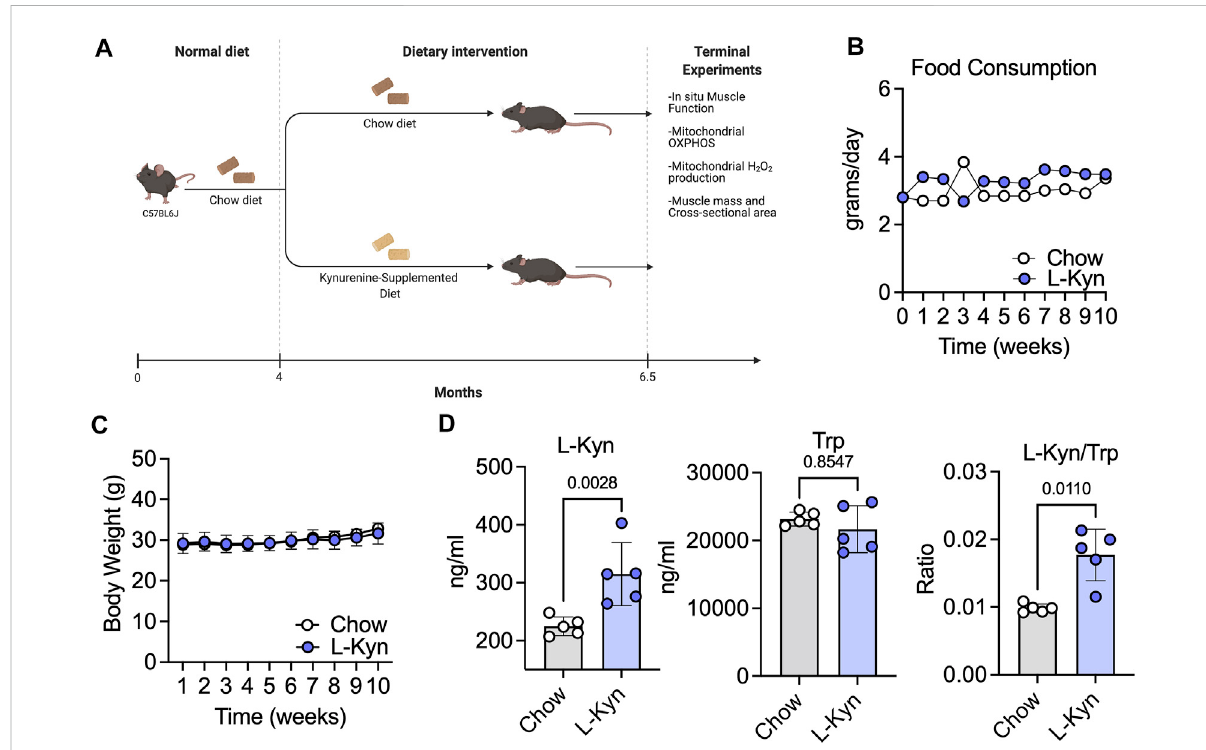
FIGURE 1 L-KynsupplementeddietincreasesplasmaL-KynlevelsandtheL-Kyn/Trpratio. (A) Graphicaldepictionofstudydesignandoutcomemeasures, created using Biorender.com. Weekly measures of (B) food consumption and (C) body weight over course of the intervention. (D) Plasma concentrations ofL-Kyn, Trp, and theL-Kyn/Trpratio assessedby liquid chromatography – mass spectrometry. Error bars represent SD.N = 5/group for all panels. Data in panels B and C were analyzed using a two-way ANOVA, whereas data in Panel D were analyzed using a two-tailed Student ’ s t